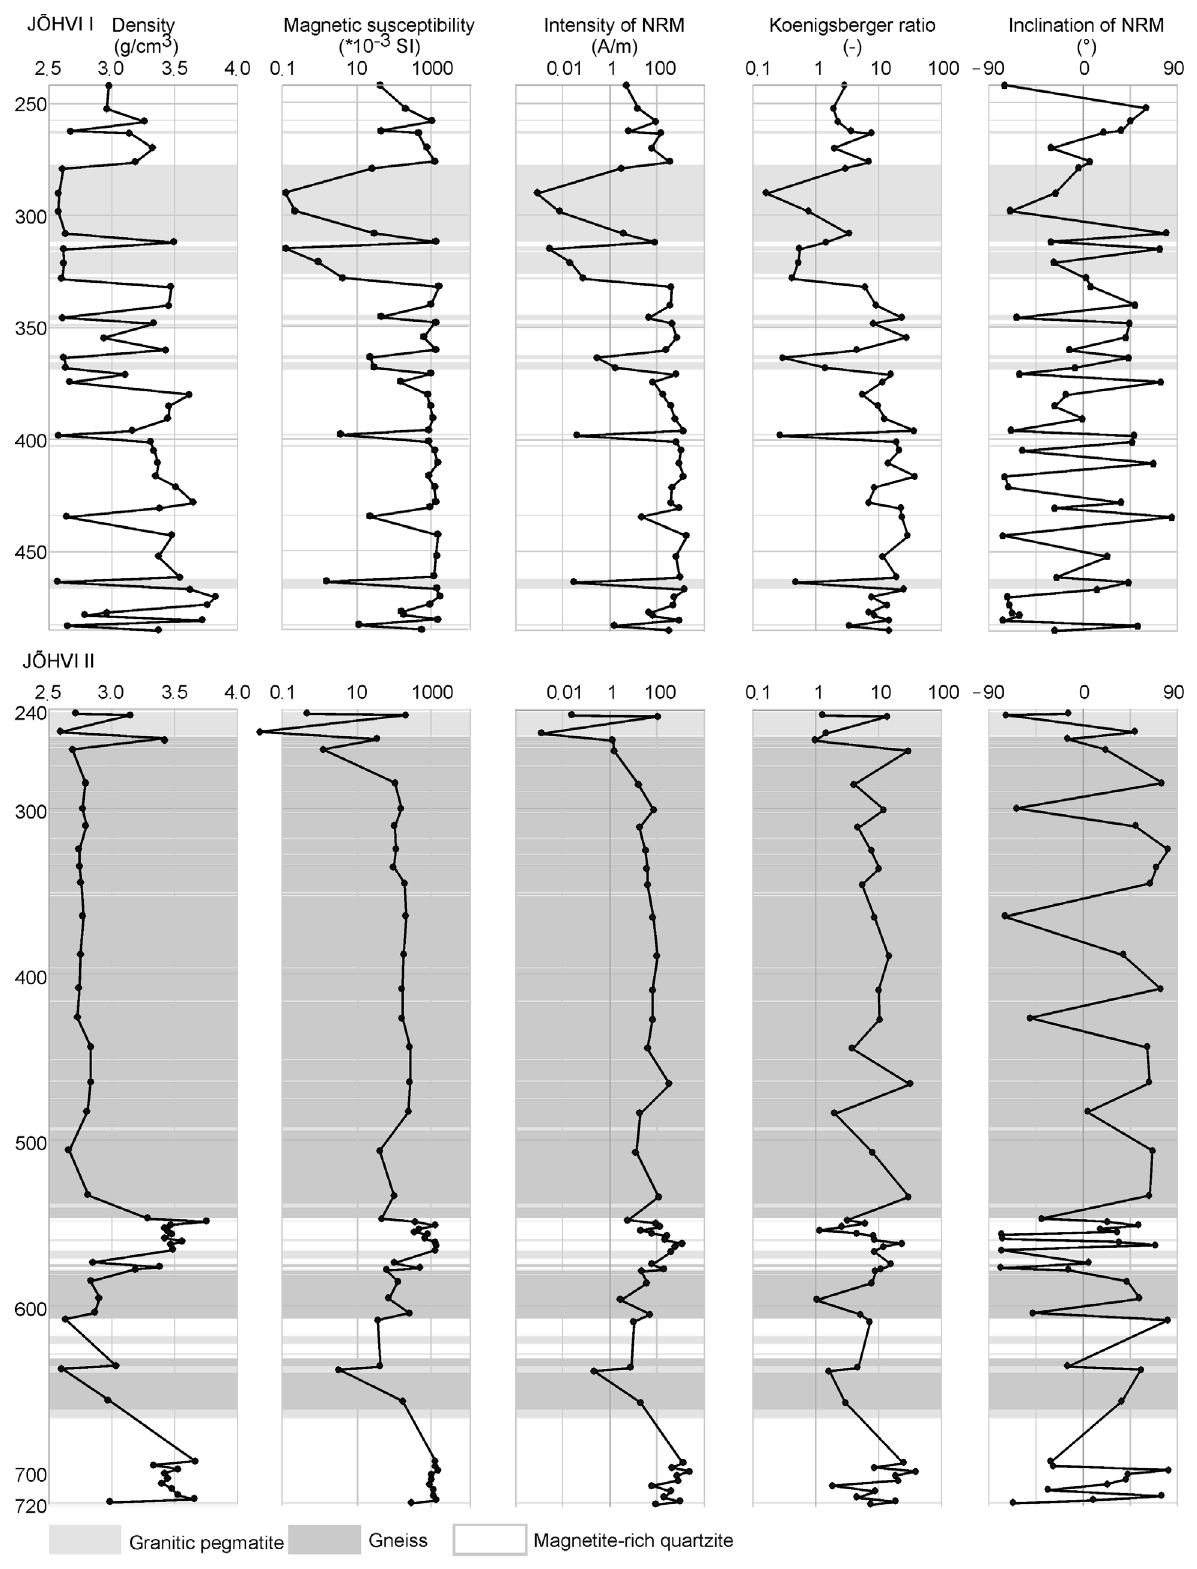
Fig. 2. Petrophysical properties of rocks in the Jõhvi I (above) and II (below) drill